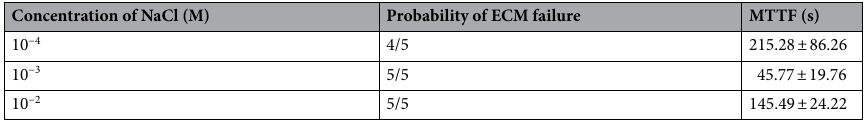
Table 2. Probability of ECM failure and mean time-to-fail (MTTF) of Sn at various Cl − concentrations. Standard errors were calculated from the total number of failures during